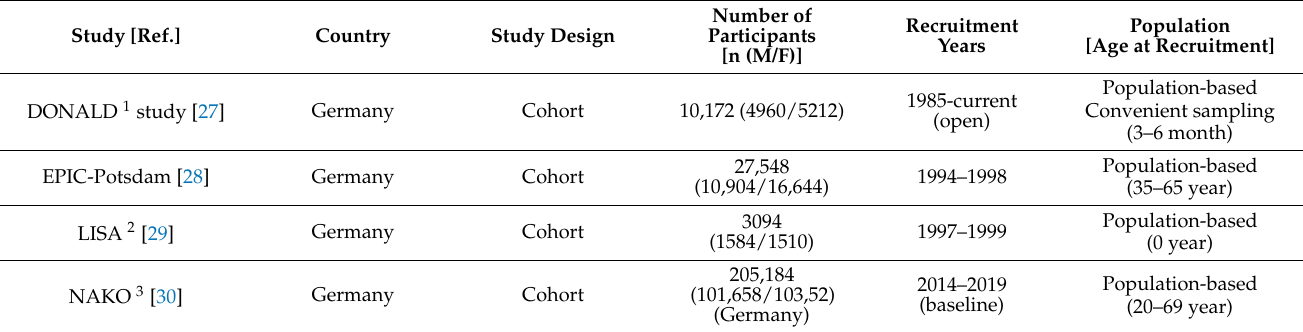
Table 1. Characteristics of the identified observational studies within the KP-INTIMIC consortium. Study [Ref.]